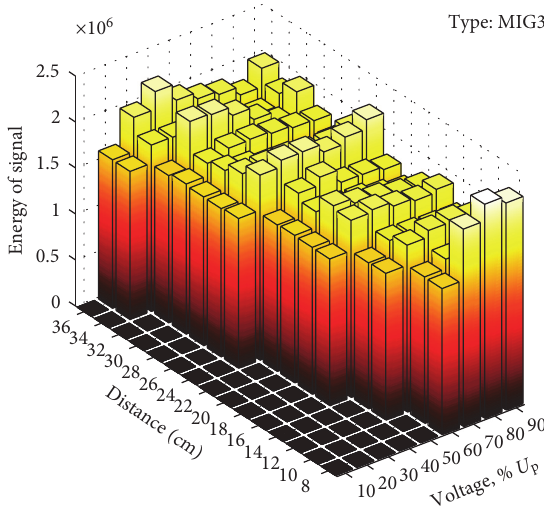
Figure 10: Dependency of voltage and distance on the number of wavelength components for the AlMg5 line.